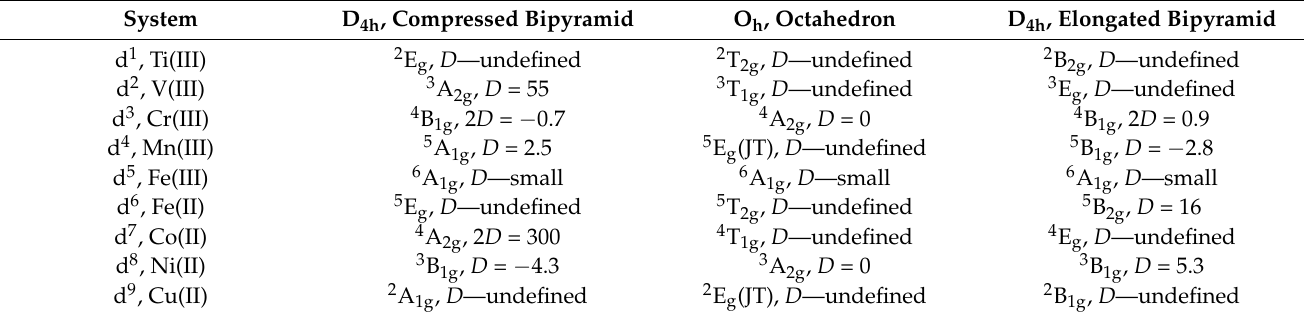
Table 4. Review of the SH formalism for hexacoordinate systems with tetragonal distortion 1